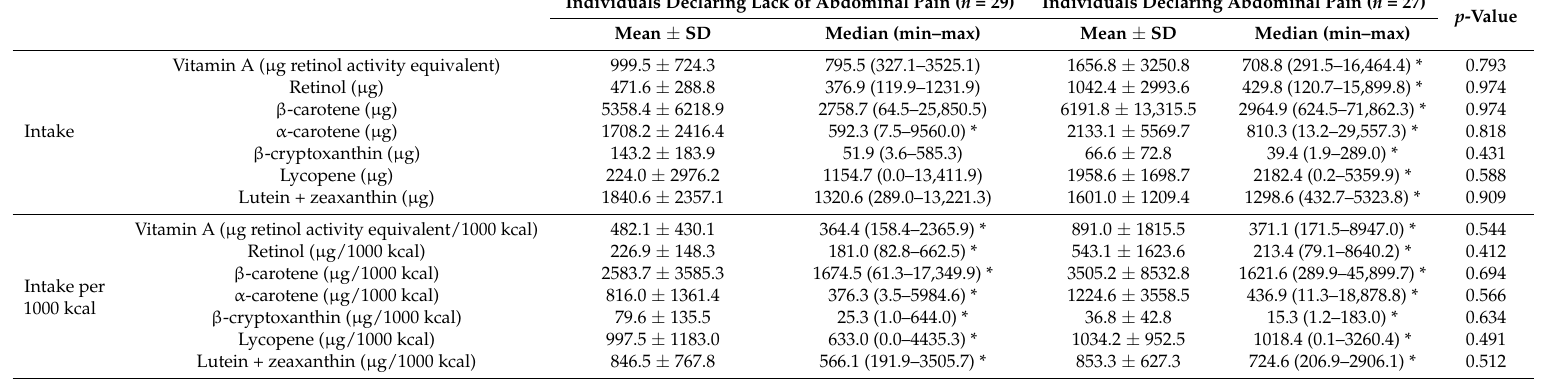
Table 1. The levels of retinoid intake in groups of individuals with ulcerative colitis declaring either a lack or presence of abdominal pain (comparison conducted using U Mann-Whitney test).